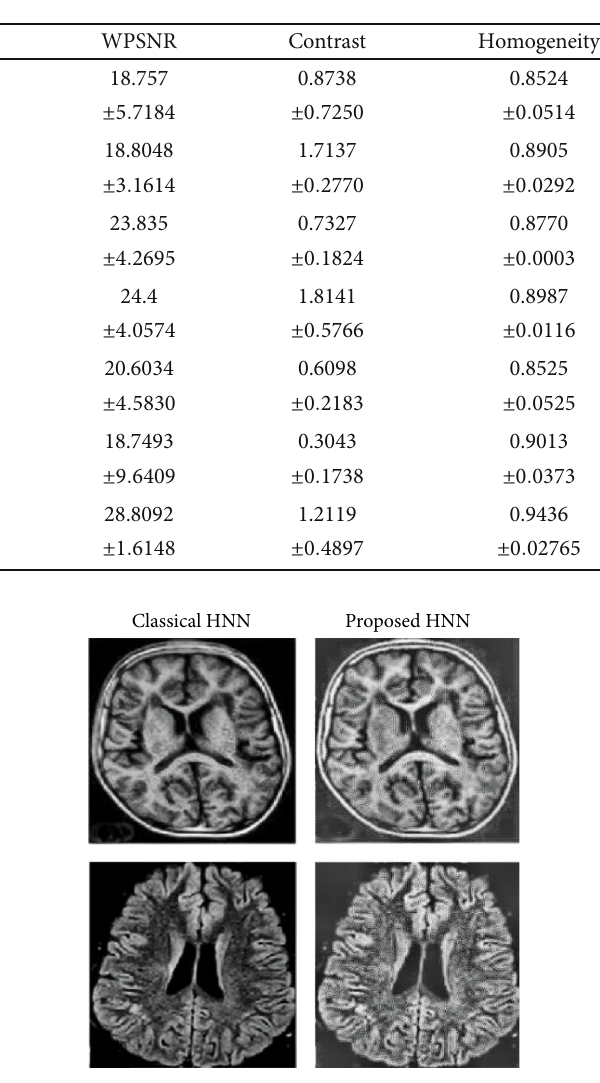
Table 1: Comparison of mean μ and standard deviation σ of performance evaluation metrics of the proposed method and existing state-of- the-art algorithm.